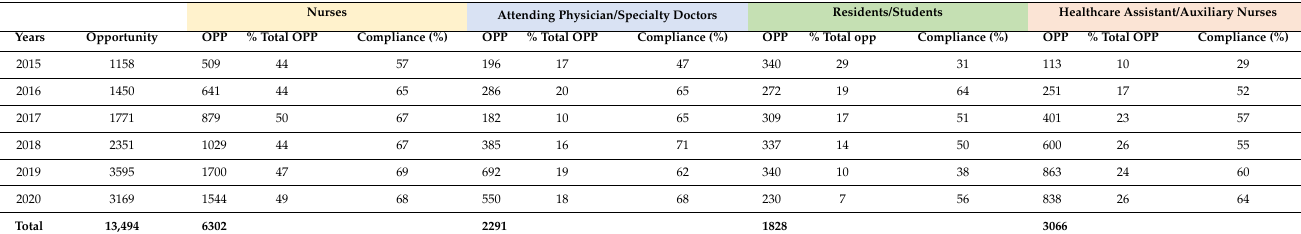
Table 2. Adherence to hand hygiene per professional category per year.